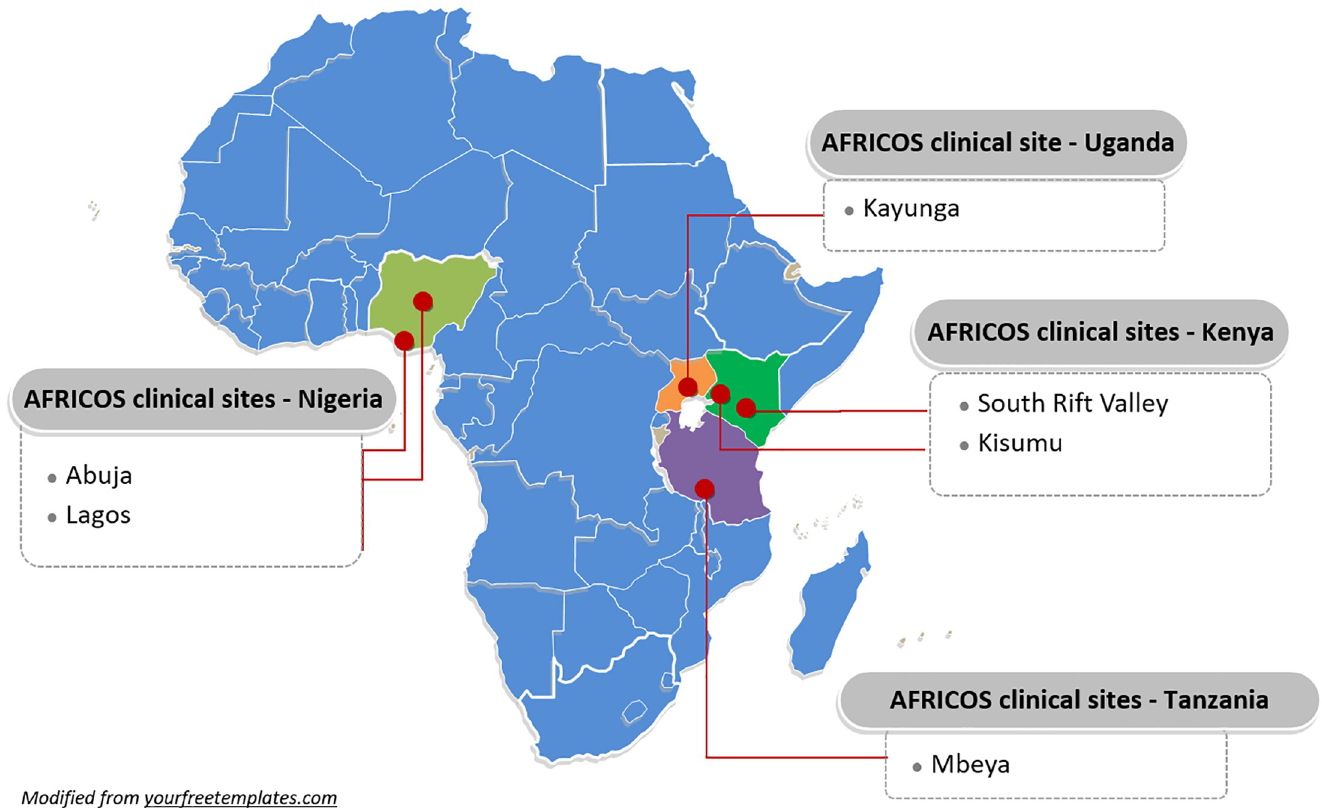
Fig 1. The African Cohort Study (AFRICOS) clinical